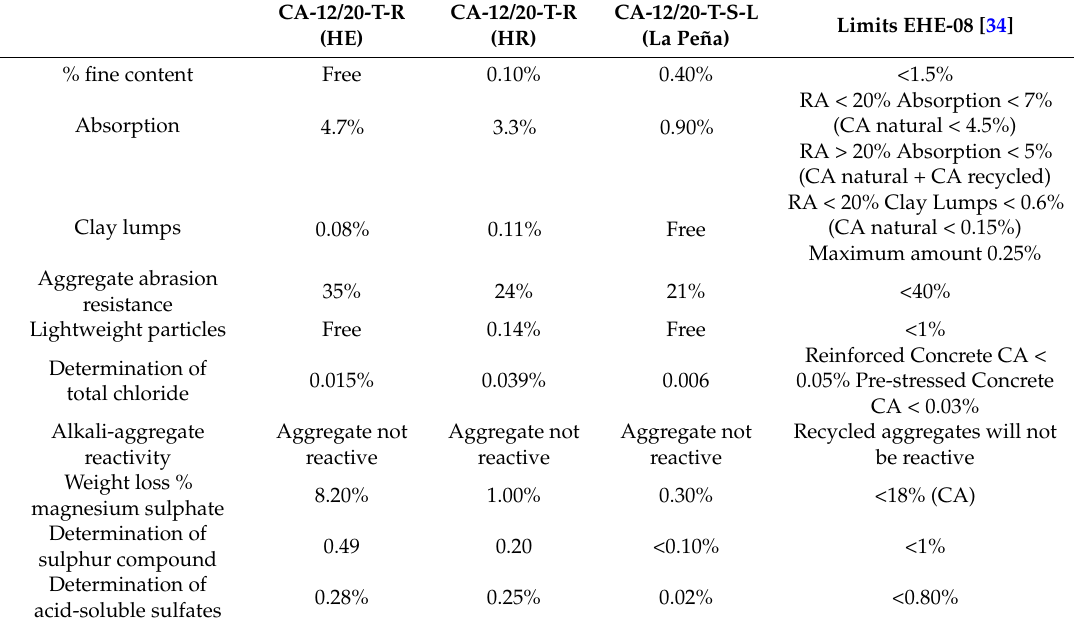
Table 4. Characterization of natural and recycled coarse